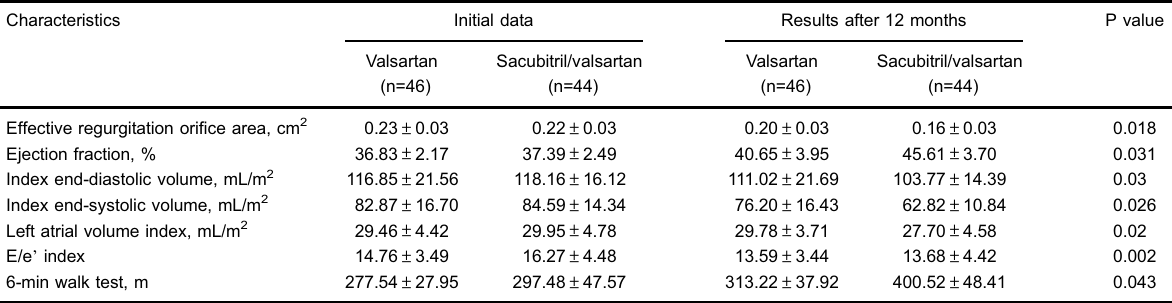
Table 5. Echocardiographic changes in patients who completed the study and changes achieved on the 6-min walk test according to treatment.